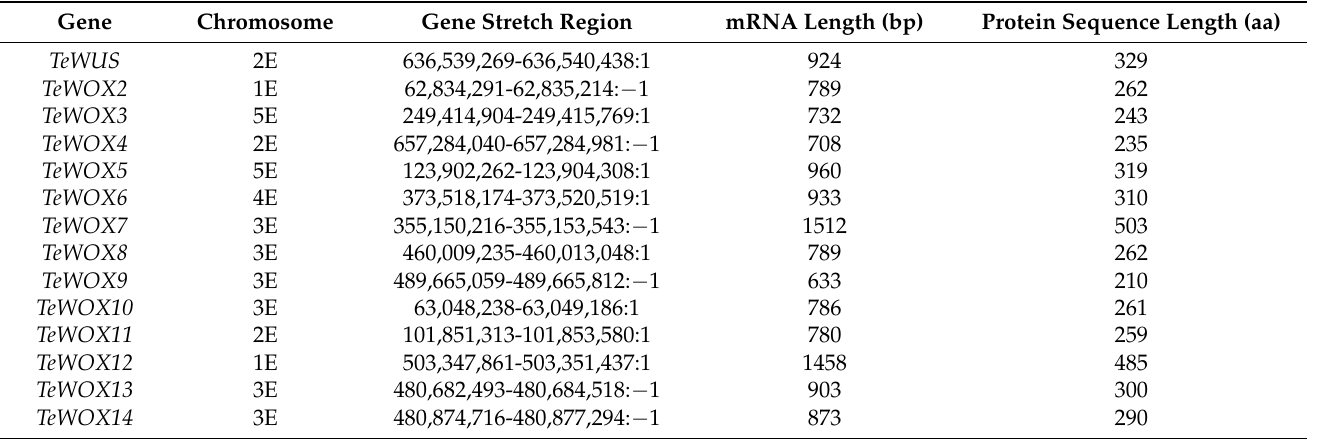
Table 4. Characteristics of TeWOX gene family members in T. elongatum